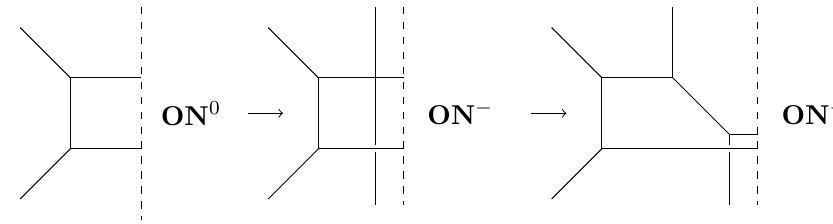
Figure 6 . Resolution of the orientifold, ON 0 ! ON (cid:0) + NS5, and the conifold singularity gives rise to the \resolved" brane web proposed in